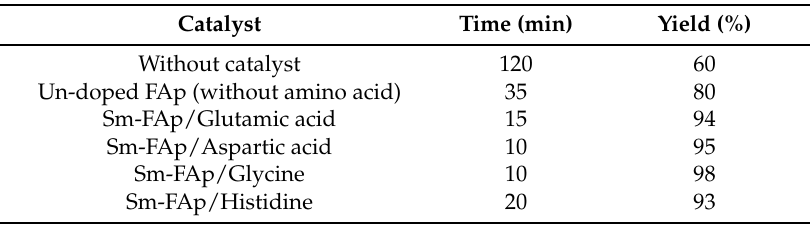
Table 2. Catalytic performance of catalysts in the typical reaction a